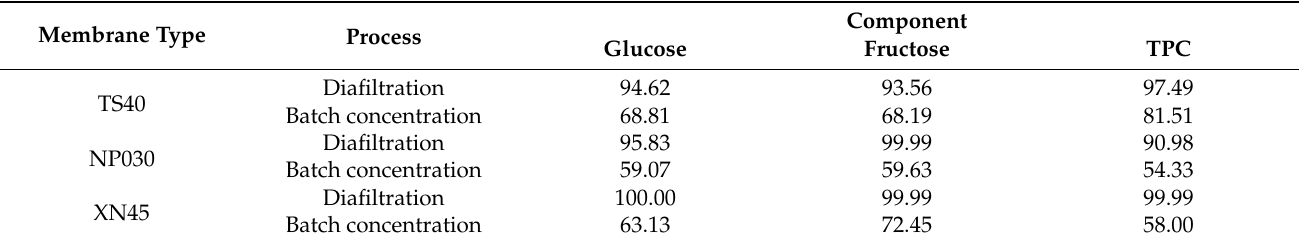
Table 3. Mass balance (%) of glucose, fructose, and TPC in diafiltration and batch concentration processes for selected